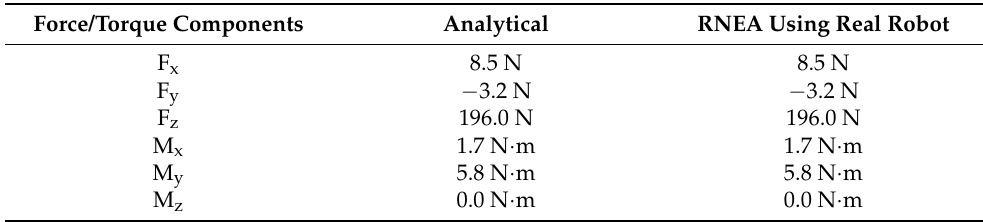
Table 2. Forces and torques generated at connection point P. Force/Torque Components